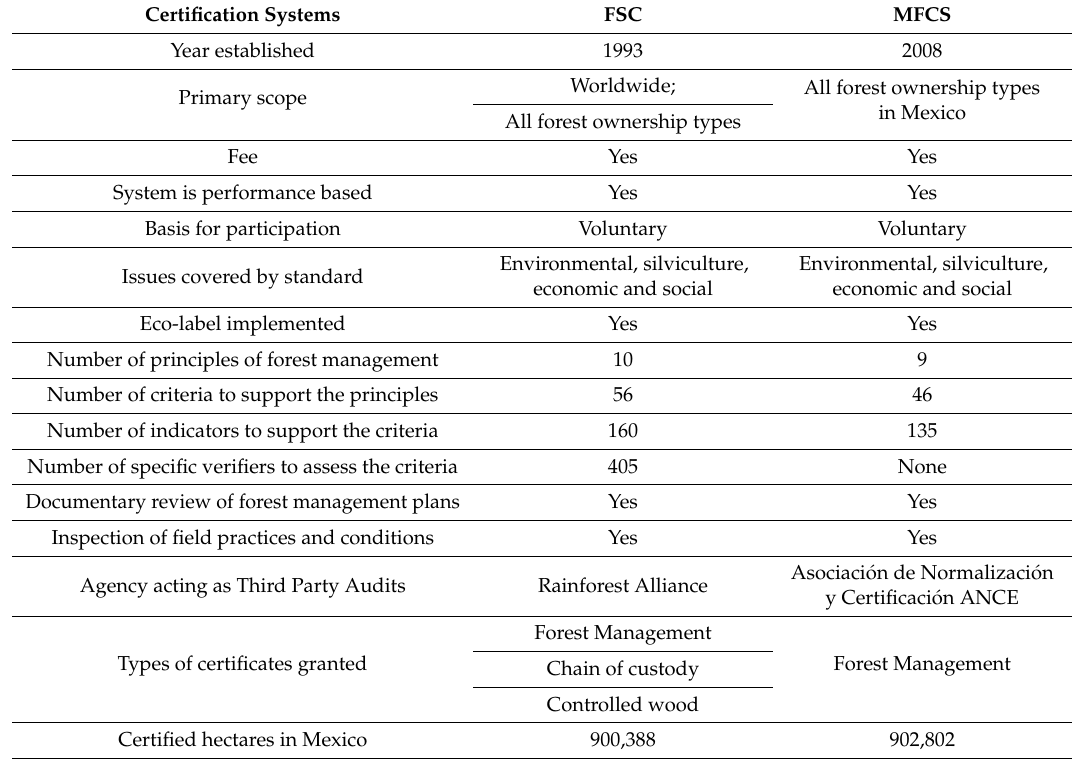
Table 2. Comparison of FSC and MFCS Forestry Certification Structures in